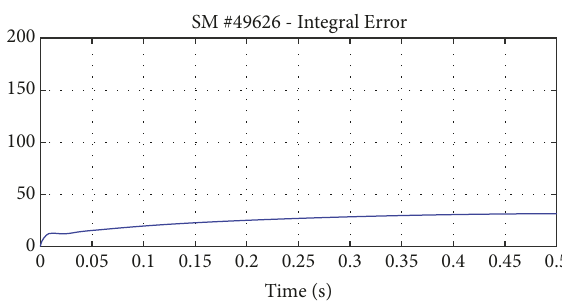
Figure 13: Sliding mode integral error (Shot #49626).